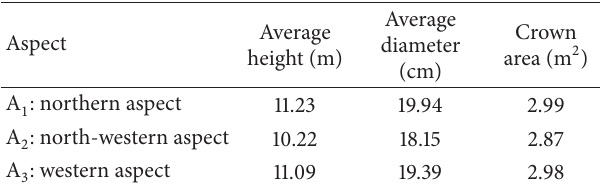
Table 1: Height, diameter, and crown area of Pinus roxburghii in the study